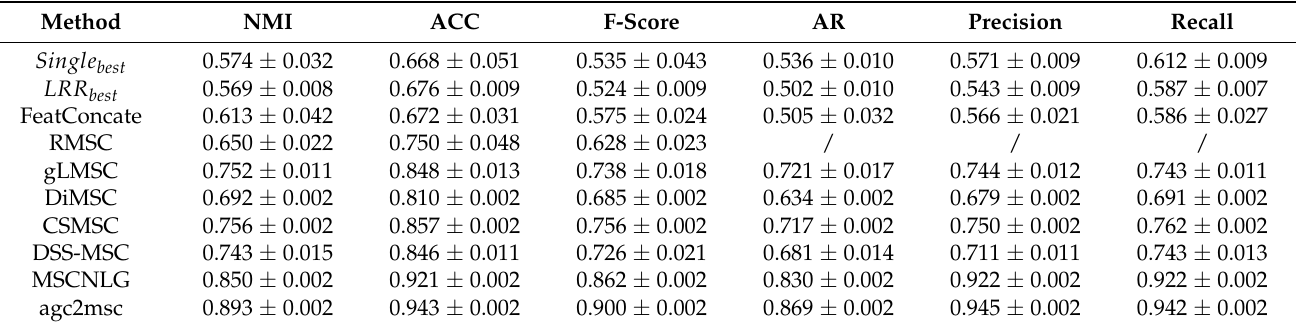
Table A4. Clustering results of the ten methods on MSRCV1.